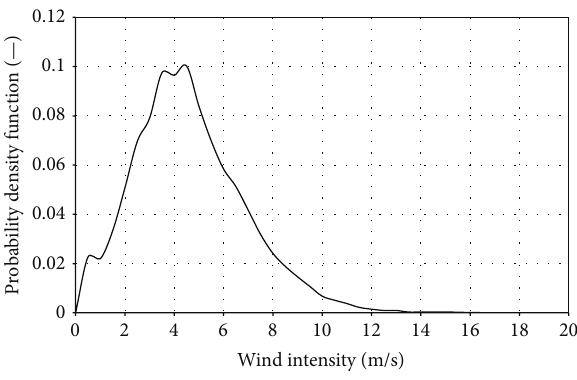
Figure 9: Test case site wind probability density function.